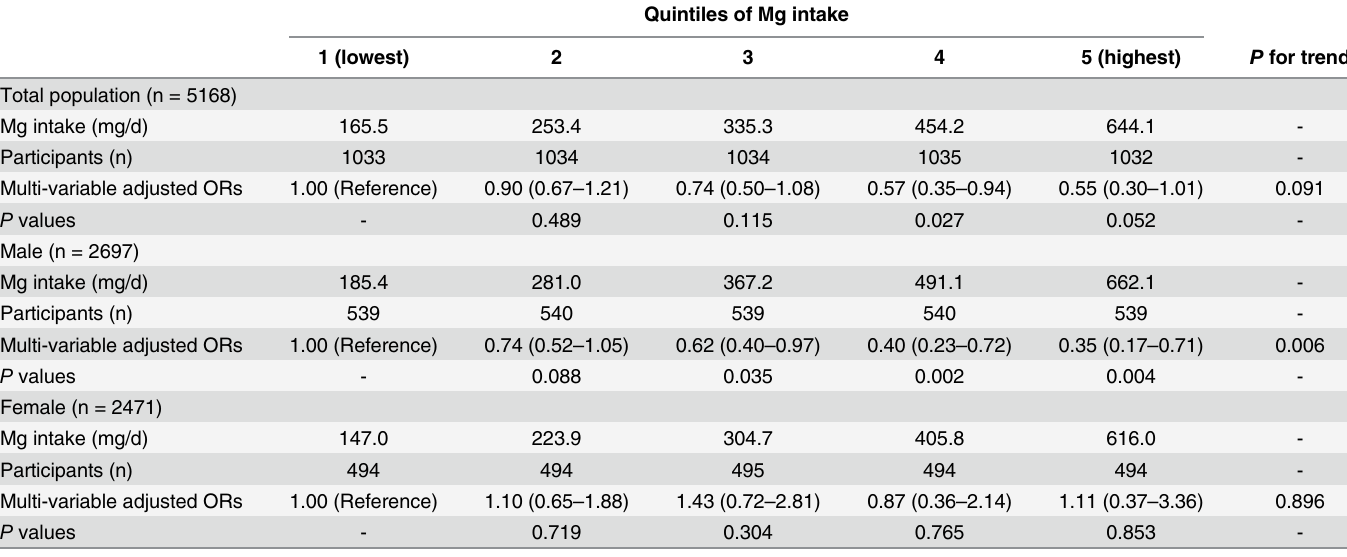
Table 3. Multivariable-adjusted relations of dietary of Mg intake and HU (n = 5168). Data are adjusted OR (95% CI), unless otherwise indicated; Mg, magnesium; n, number; HU,